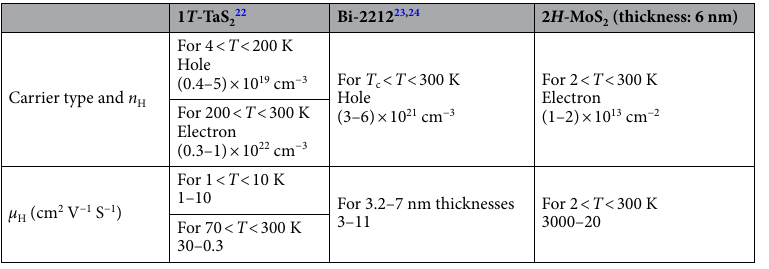
Table 1. Representative carrier type, carrier density ( n H ) and Hall mobility ( μ H ) for three vdW